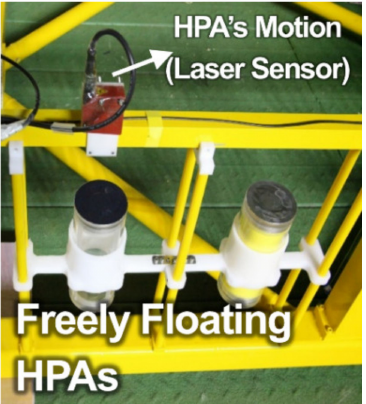
Figure 9. Measurement of HPA’s